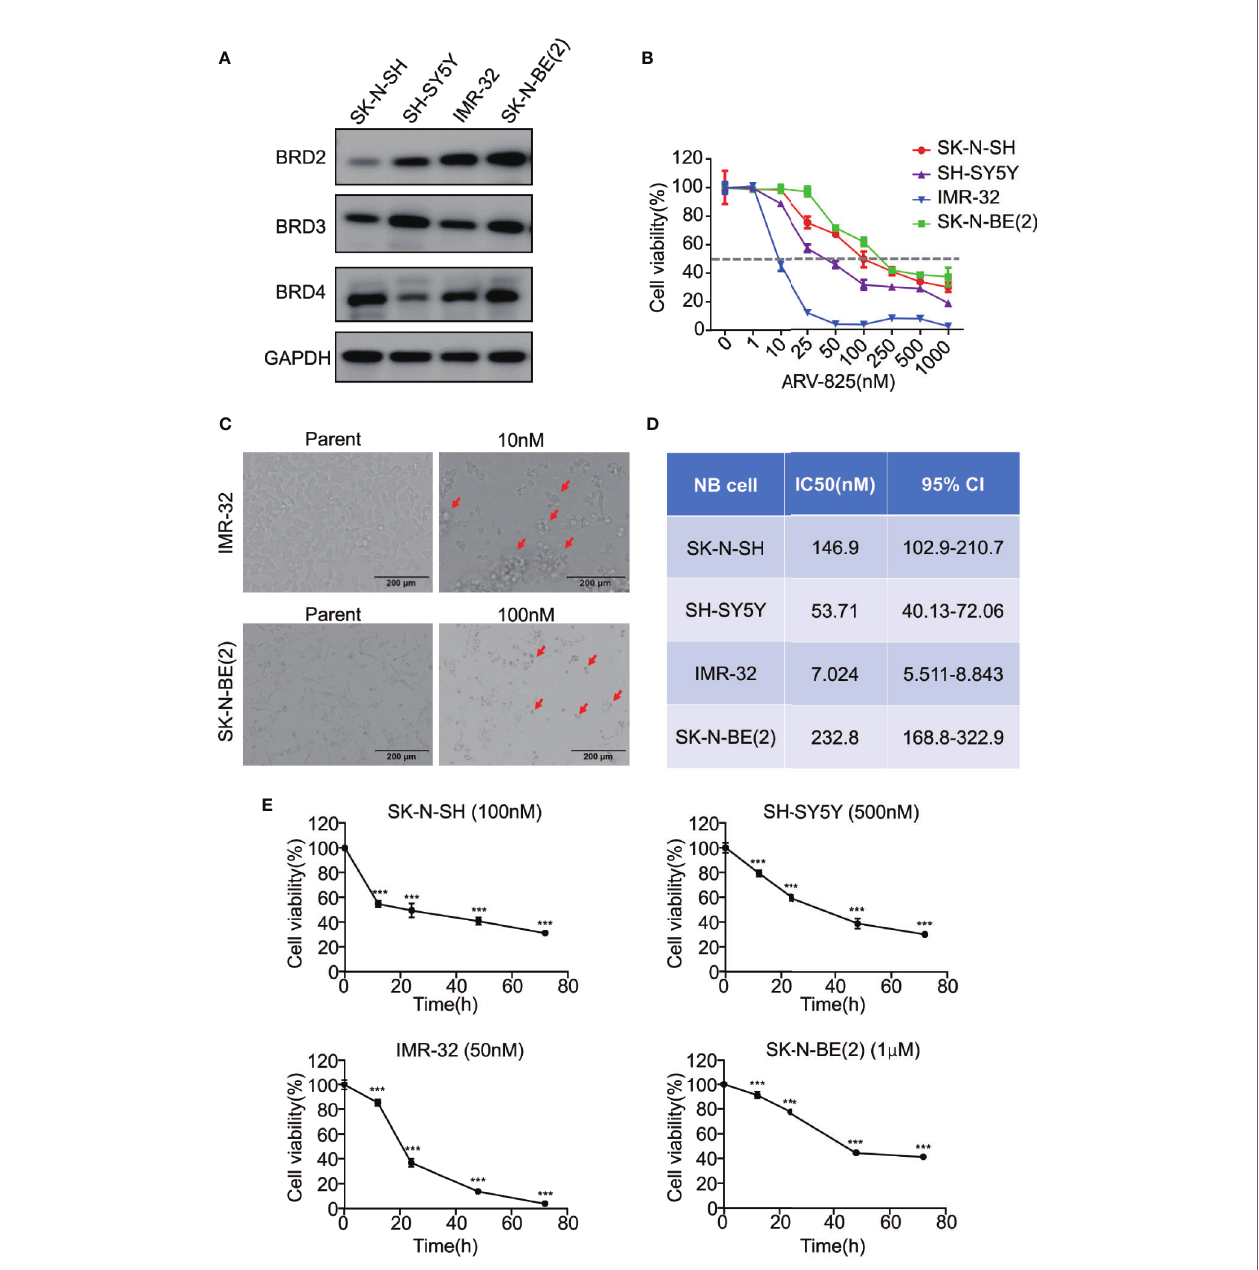
FIGURE 2 | ARV-825 inhibits cell viability in NB cells. (A) Western blot analysis showed basal BET protein expression level in NB cells. (B) Cell viability of NB cells treated with serial concentrations of ARV-825 for 72 h. The cell viability rate was calculated as a percentage of the DMSO-treated control wells. (C) Morphology of IMR-32 (up) and SK-N-BE(2) (down) cells incubated with ARV-825 at indicated concentrations for 72 h (red arrows indicated dead cells after ARV-825 treatment). (D) The IC50 value of ARV-825 in different NB cell lines. (E) Cell viability of NB cells treated with ARV-825 at various times. (SK-N-SH were treated with 100 nM ARV-825; SH-SY5Y were treated with 500 nM ARV-825; IMR-32 were treated with 50 nM ARV-825; SK-N-BE(2) were treated with 1 m M ARV-825). *** p <